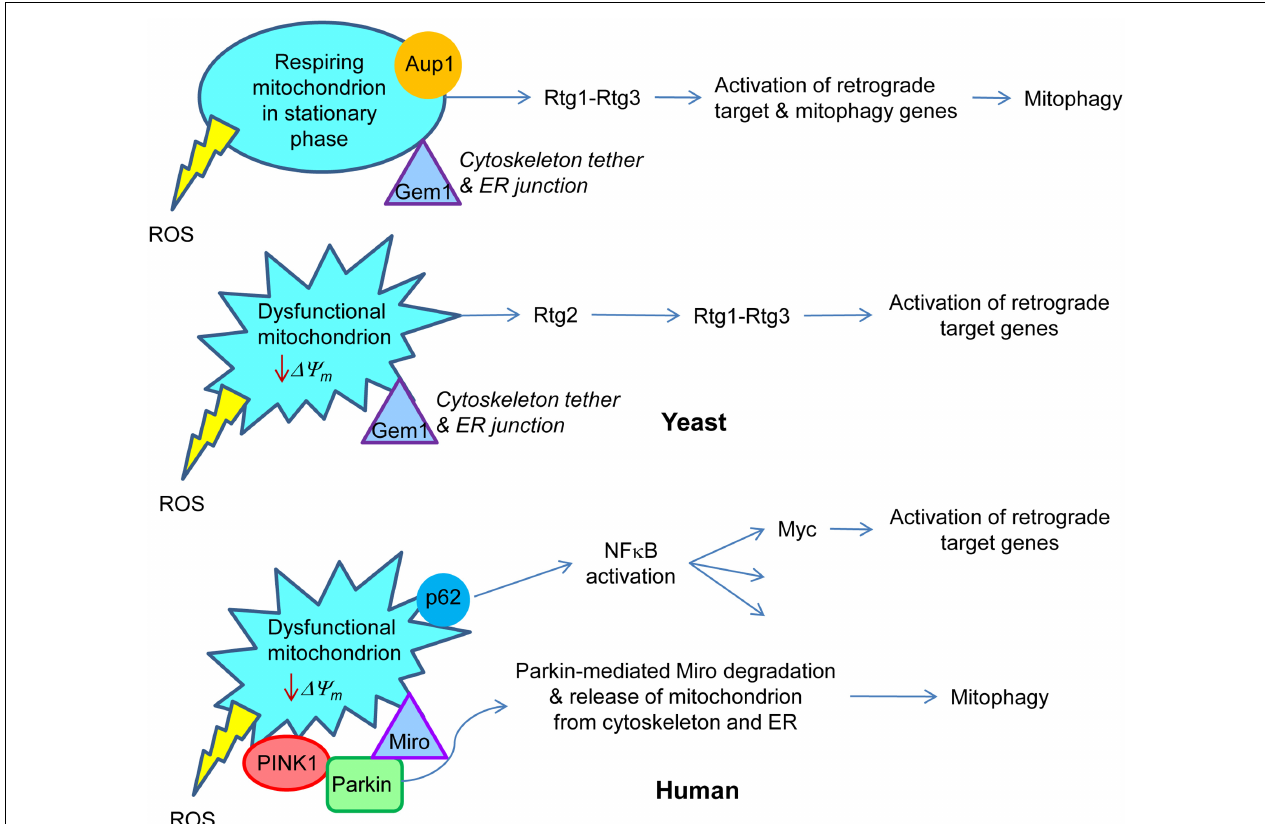
FIGURE 2 | Retrograde signaling in yeast and human. In yeast, respiring mitochondria in non-dividing, stationary phase cells signal the retrograde response that activates both retrograde response target genes, similar to those in dividing cells, and mitophagy genes.This results in the metabolic adaptation to stationary phase. Aup1, a protein phosphatase in the intermembrane space in mitochondria, is essential for this gene induction. Rtg1–Rtg3 is the retrograde transcription factor. On the other hand, dysfunctional mitochondria in growing cells trigger the classical retrograde response with activation of retrograde response target genes. Rtg2 plays an essential role in this process. Gem1 is a Miro homolog in yeast which is important for maintaining junctions between mitochondria and the endoplasmic reticulum. By analogy with mammalian cells, it would also